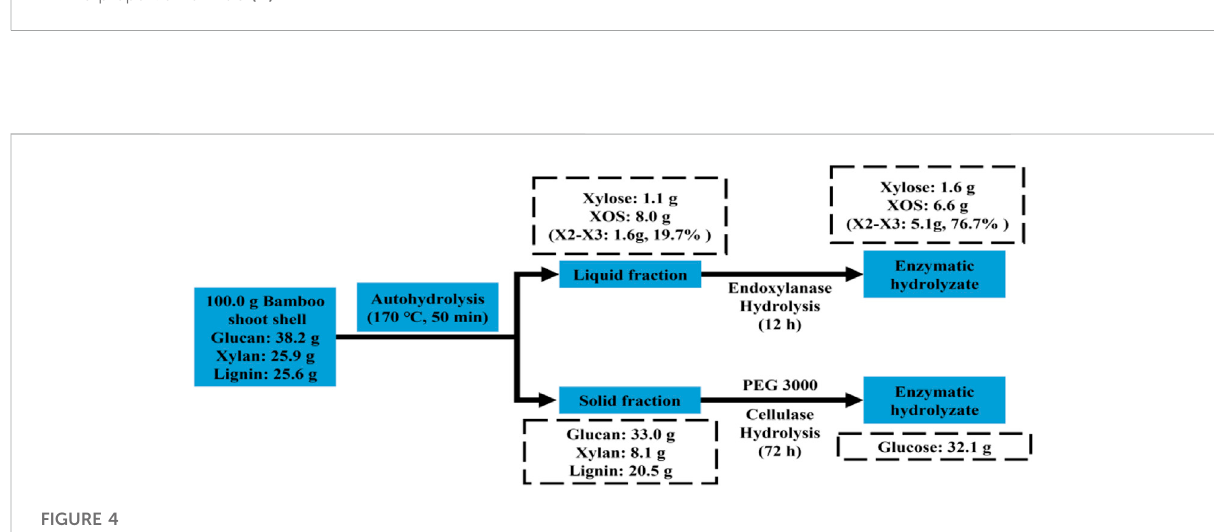
FIGURE 4 Mass balance of BSS during the established